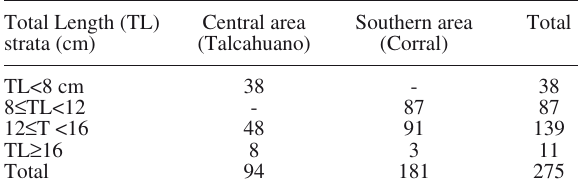
Table 1. – Number of otoliths, which were selected per length